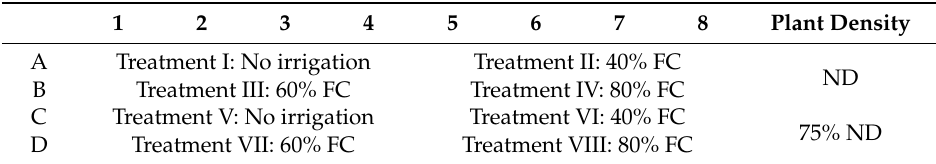
Table 1. Winter wheat plot arrangement and irrigation treatments [5].